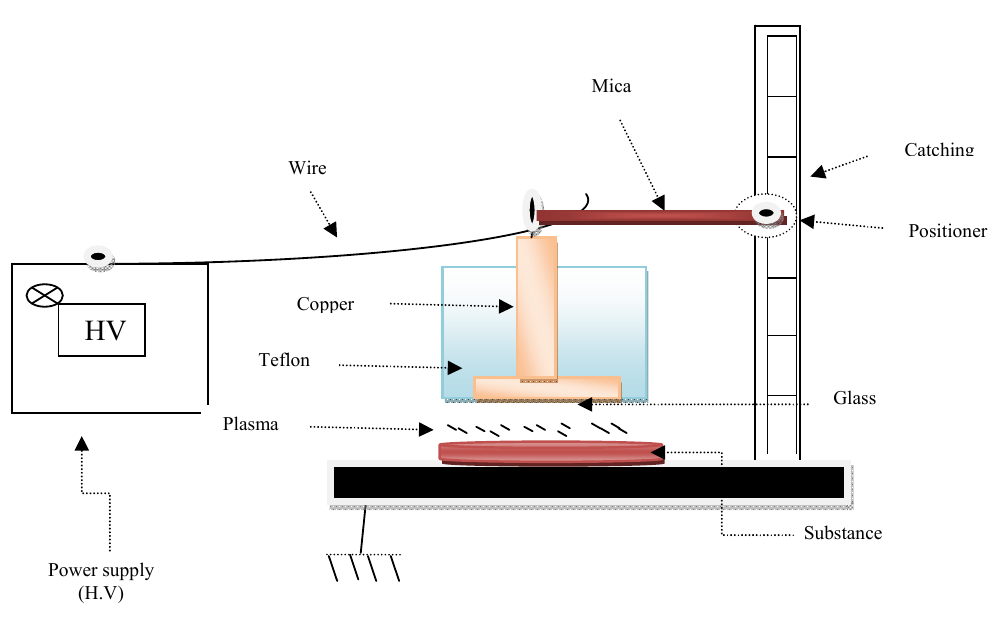
Fig.1: Schematic diagram for the DBD